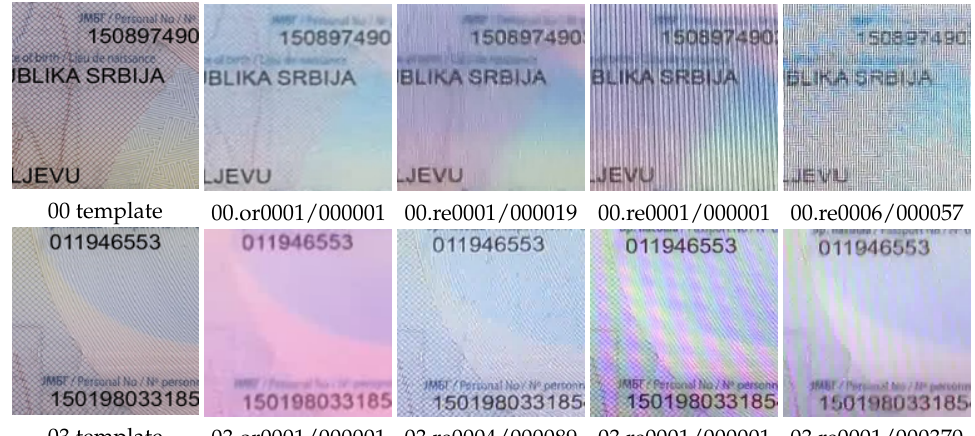
Figure 7. Zones from geometry-normalized images for template (column 1), original (column 2) and recaptured documents (column 3–5), type